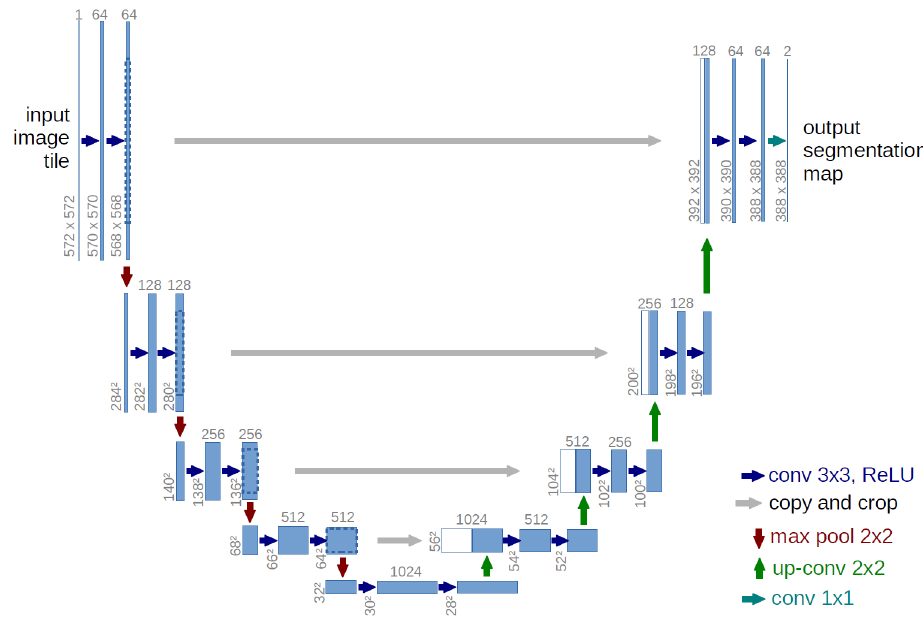
Figure 1. U-Net deep learning neural network architecture (courtesy [56]).